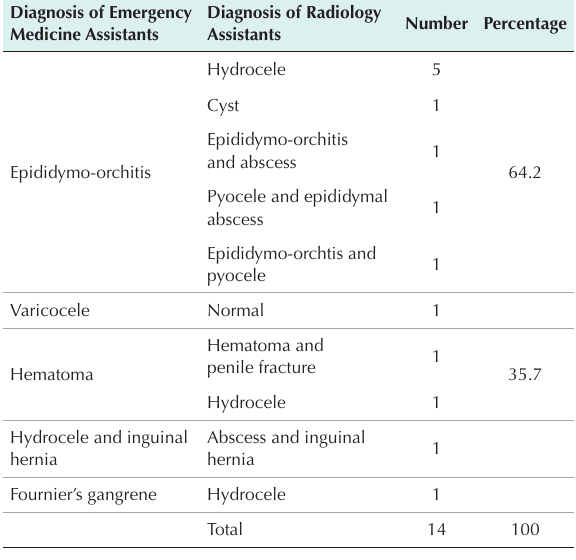
Table 3. Cases With the Lack of Contingency Between the Diagnosis of Performed Ultrasound by Radiology Assistants and Emergency Medicine